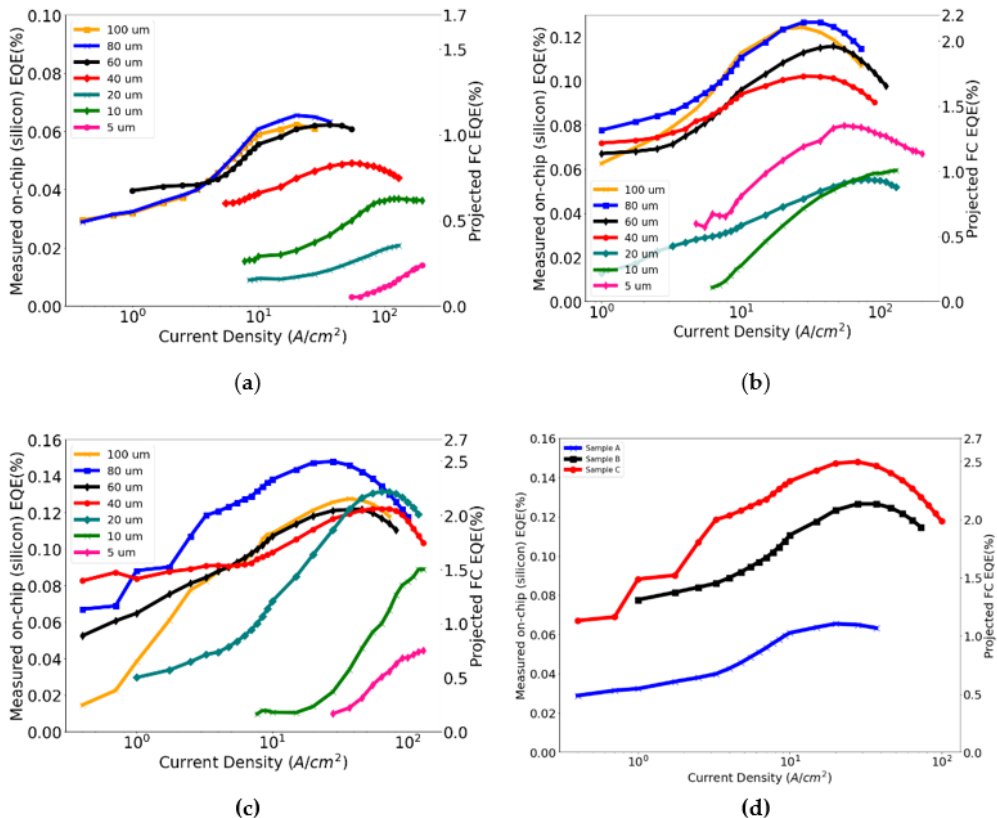
Figure 5. EQE plots for 5 – 100 µm microLEDs for samples ( a ), ( b ), and ( c ), respectively ( d ) EQE comparison for highest EQE device from each chip (80 µm) .